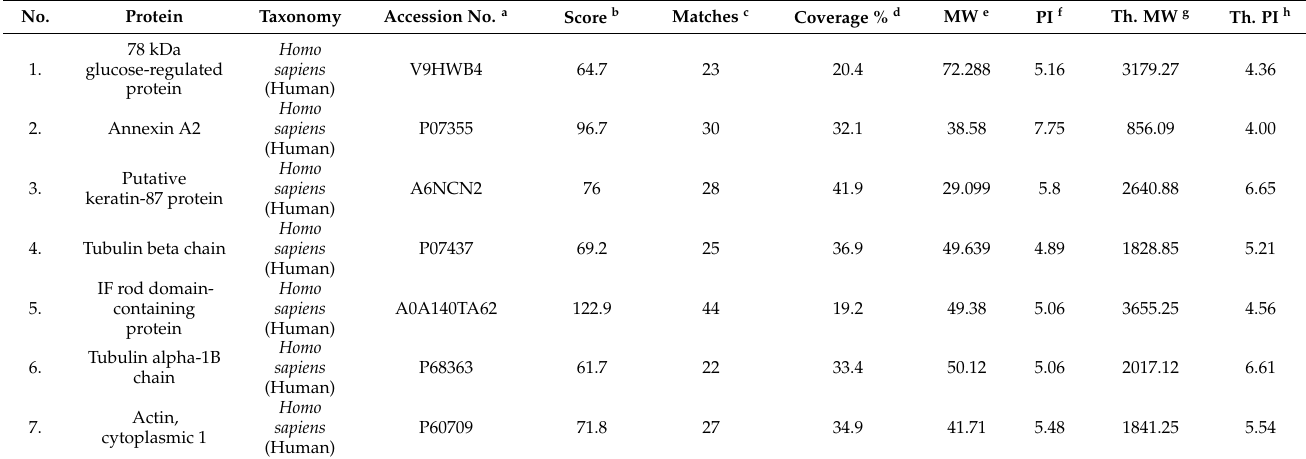
acid coverage of. e Experimental molecular weight (kDa). f Experimental PI. g Theoretical molecular weight (kDa) from ExPASy database. h Theoretical pI from ExPASy